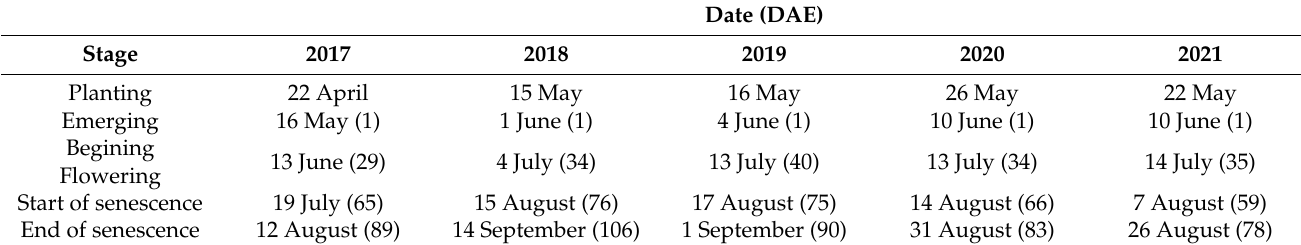
Table 1. Dates of phenological stages in five studied crop